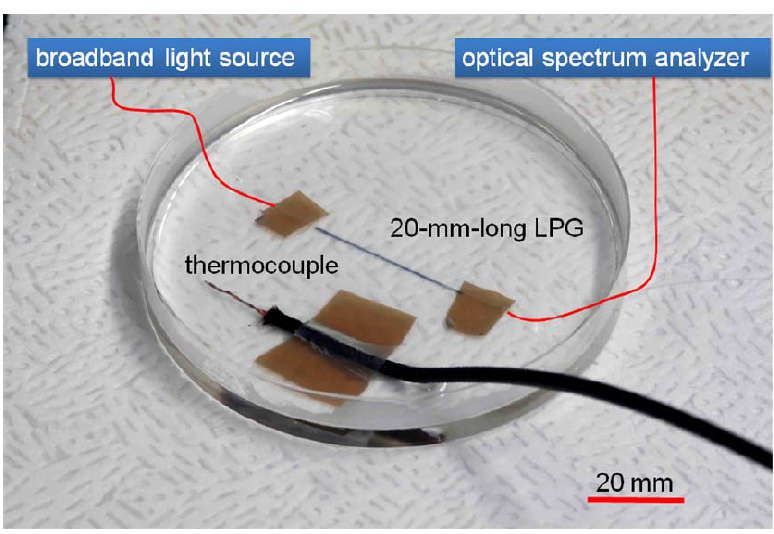
Figure 11. Experimental setup for monitoring epoxy resin cure.